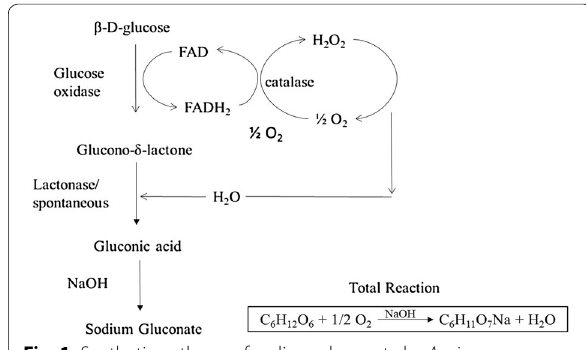
Fig. 1 Synthetic pathway of sodium gluconate by A.